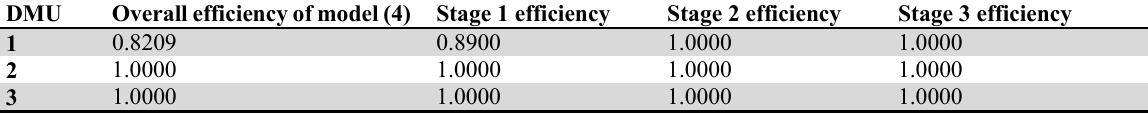
Numerical results for nonlinear models (1) to (4), without linearization for data in Table 1 DMU